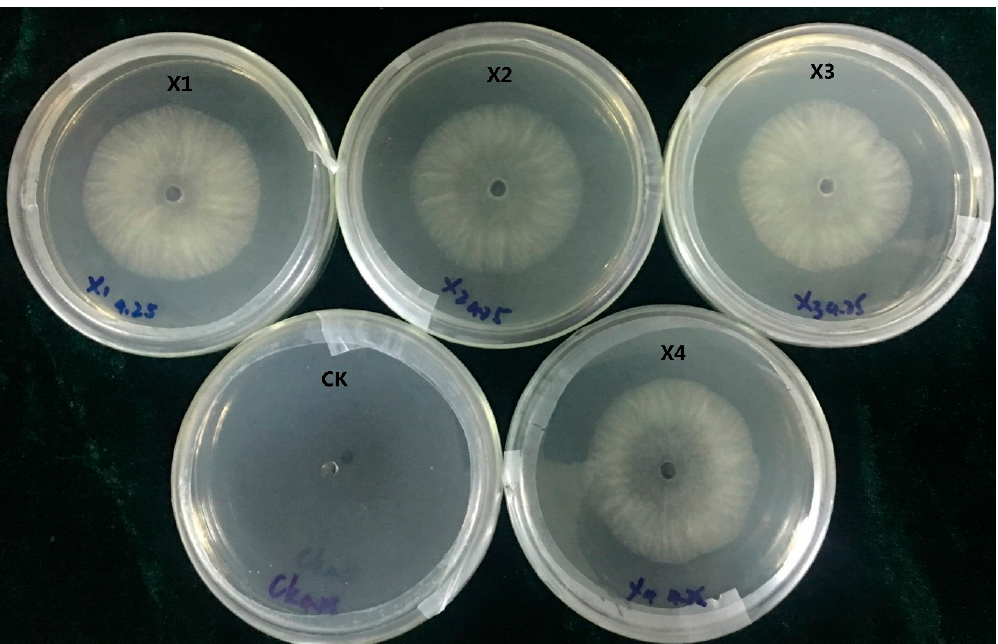
Figure 3. The growth of the transformants on HmB plates. ( CK ), wild-type strain X-3314; ( X1 – X4 ), transformants. The transformants and wild-type strain were cultured on PDA plates containing 16 µ L of 1 g / 20 mL HmB, respectively. The figure shows that the transformant strains ( X1 – X4 ) could grow on PDA plates, while the wild-type failed to grow.